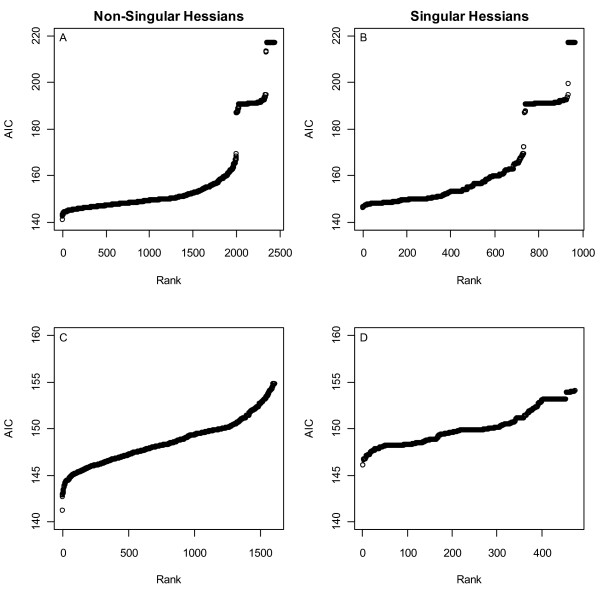
AIC model densities versus AIC model rank. A) and C) show models that had non-singular Hessians (matrices of objective function second derivatives) at their optimums; B) and D) are models with singular (determinant = 0) Hessians, i.e. models that converged onto likelihood surfaces that were flat in one direction. C) and D) show 1613 and 475 models with SSEs < twice the minimum SSE.